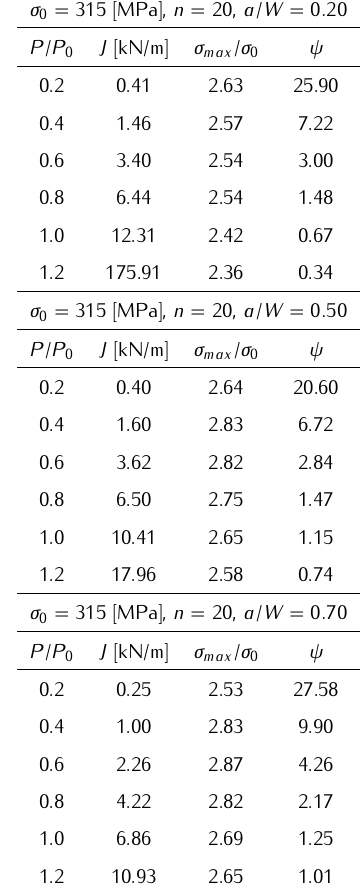
Table A3. Numerical results for CC(T) specimens characterized by yield stress σ MPa and work hardening exponent 0 = 315 in R-O relationship n = 10 σ n = 10, a/W = 0 . 20 0 = 315 [MPa],